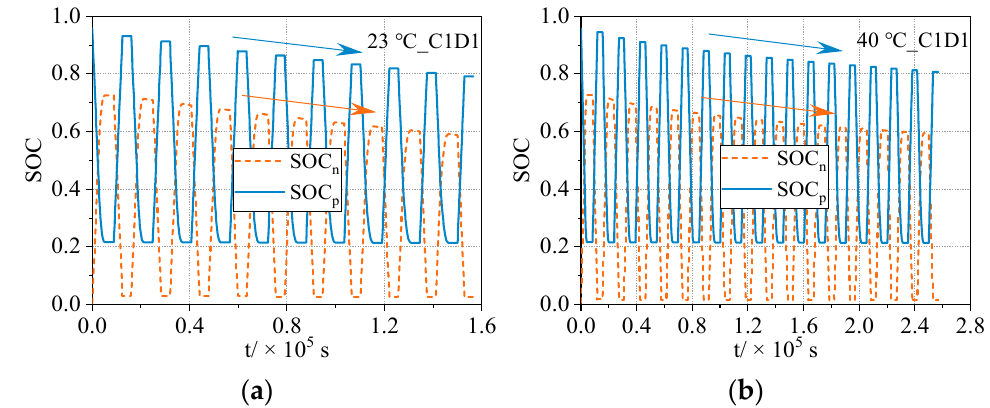
17 of 20 Figure 19. Variations in SEI film resistance and anode porosity under different aging modes at ( a ) 23 °C and ( b ) 40 °C. In addition, only in the case of LLI was there a significant decrease in the heat of the